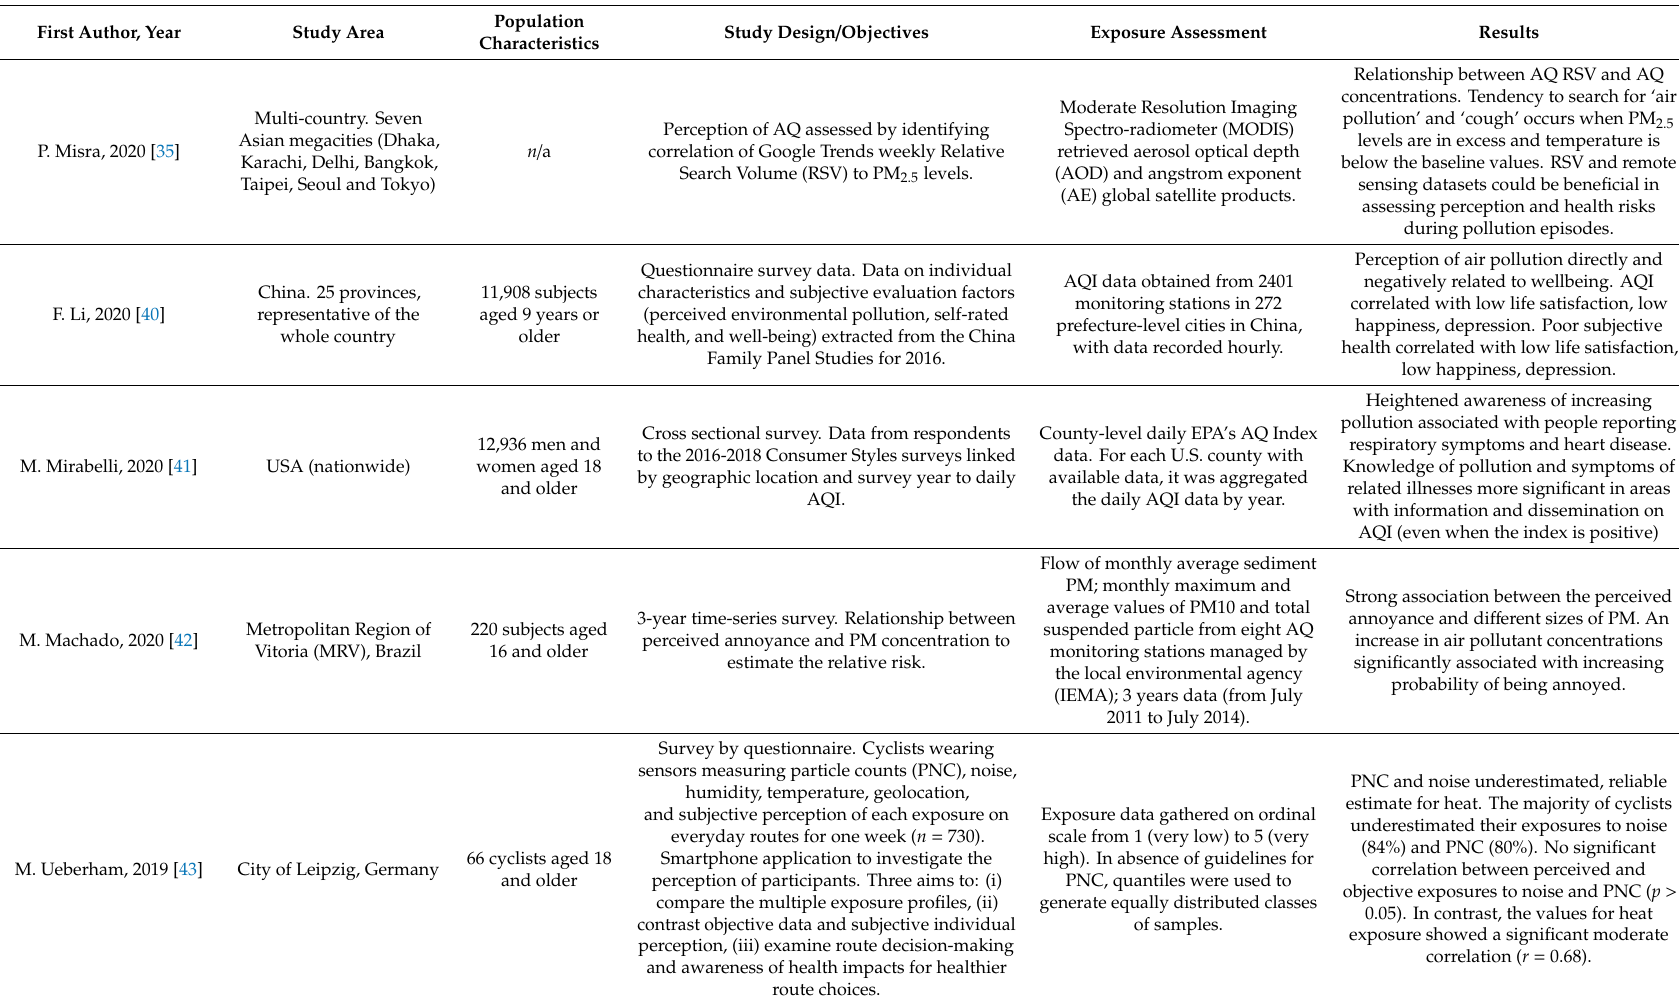
Table 1. Characteristics of included